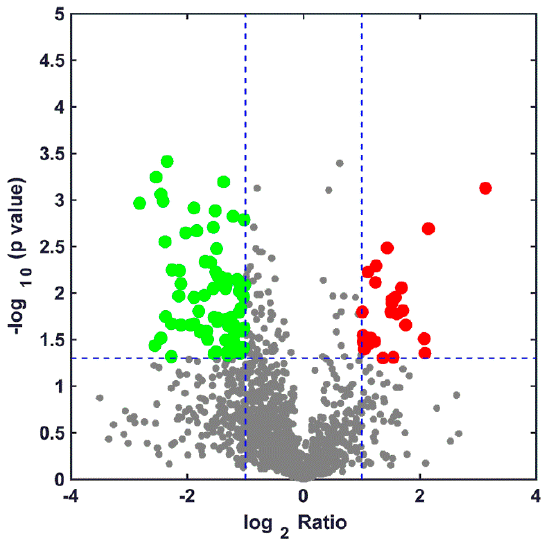
Figure 6. The numbers of identified proteins showing up-regulation and down-regulation in the control and treatment groups. The red spots represent up-regulate proteins, the blue dots down-regulated proteins, and the grey spots represent unchanged proteins in both treatment groups. The Log 2 Ratio indicates that the ratio between the treatment groups and the control groups takes a natural logarithm. The longitudinal coordinates indicate the magnitude of differences in the protein level. Fold change > 2, p < 0.05.